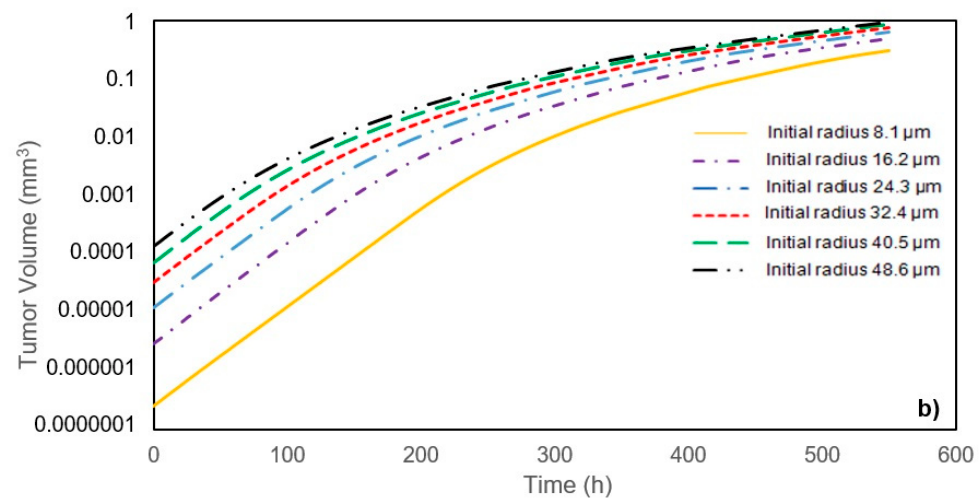
Figure 4. ( a ) E ff ect of nutrient concentrations on the tumor volume after 550 h. Tumors with 24.3 µ m initial radius are exposed to unlimited static culture mediums varying in nutrient concentrations. ( b ) E ff ect of the initial tumor radius on the growth. All of the tumors are exposed to the unlimited static culture medium with 0.8 mM glucose and 0.28 mM oxygen concentration.